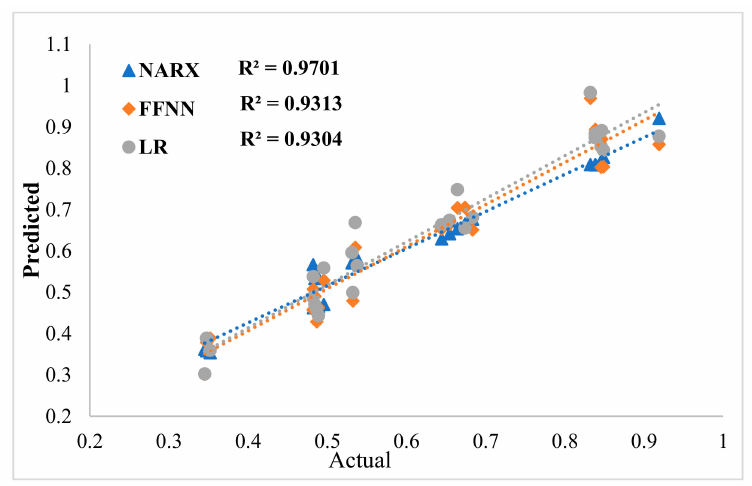
Figure 5. Relative error (RE) of the NARX model.